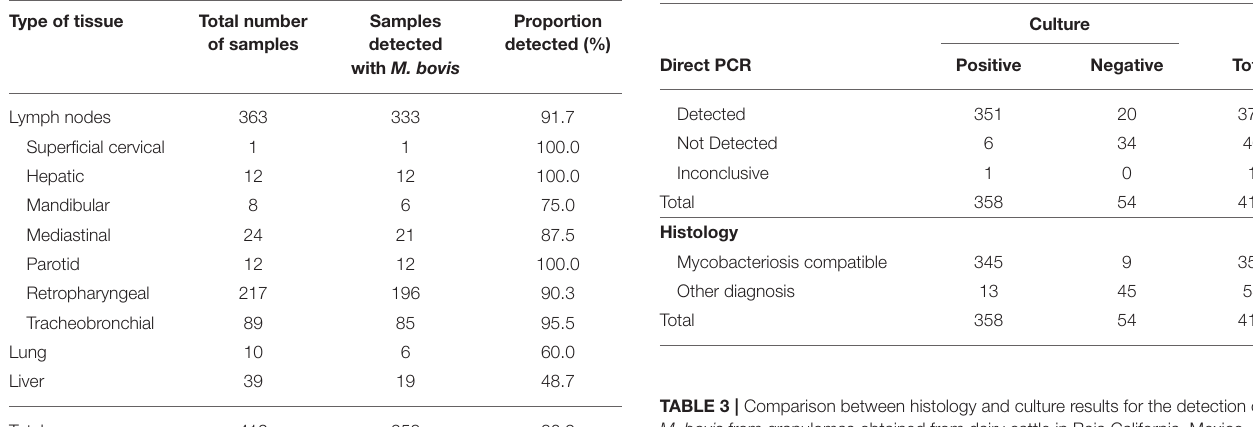
TABLE 3 | Comparison between histology and culture results for the detection of M. bovis from granulomas obtained from dairy cattle in Baja California, Mexico. Culture